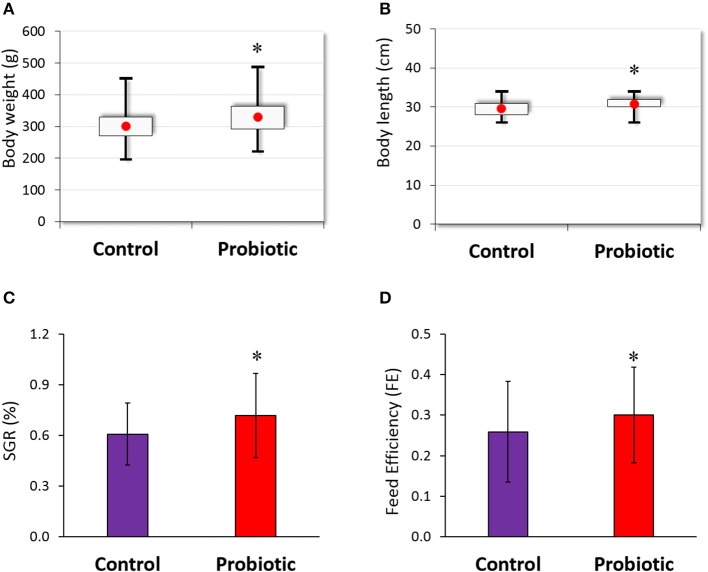
Growth performance of olive flounder (n = 48 for each group) fed with or without probiotic L. lactis WFLU12 (109 CFU/g of feed) supplemented diets. Weight gain (A), length gain (B), feed efficiency (C), and specific growth rate (D) of olive flounder were measured during the experiment period. Each bar represents mean value with standard error (SE). *p < 0.05 compared to the control.